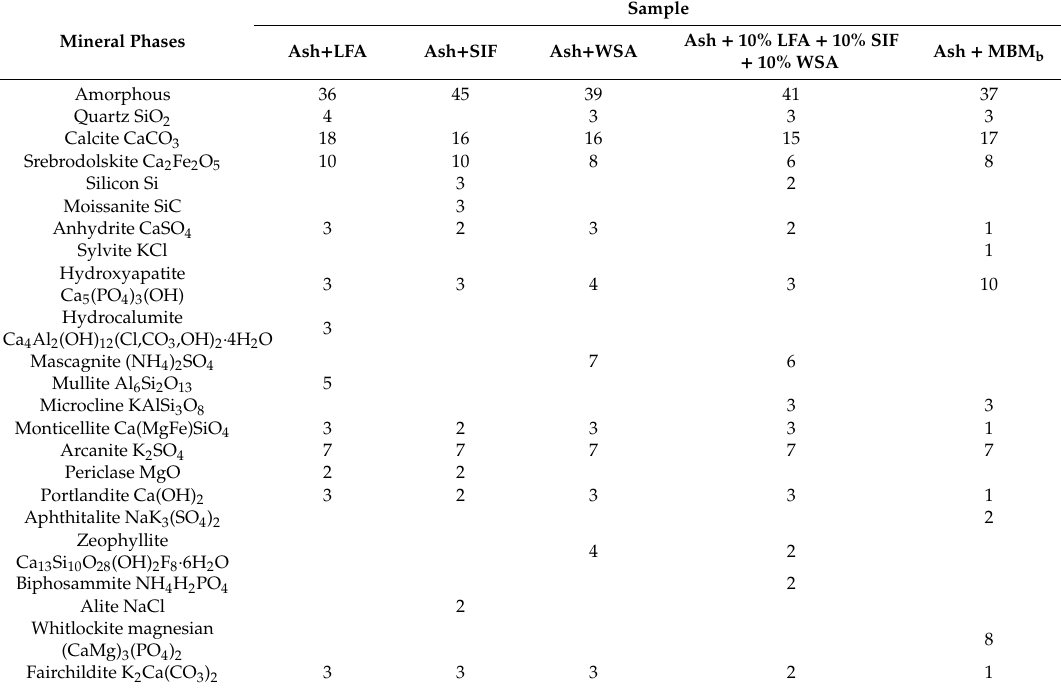
Table 6. Quantitative mineralogical analysis of ash with 20% w / w stabilizers